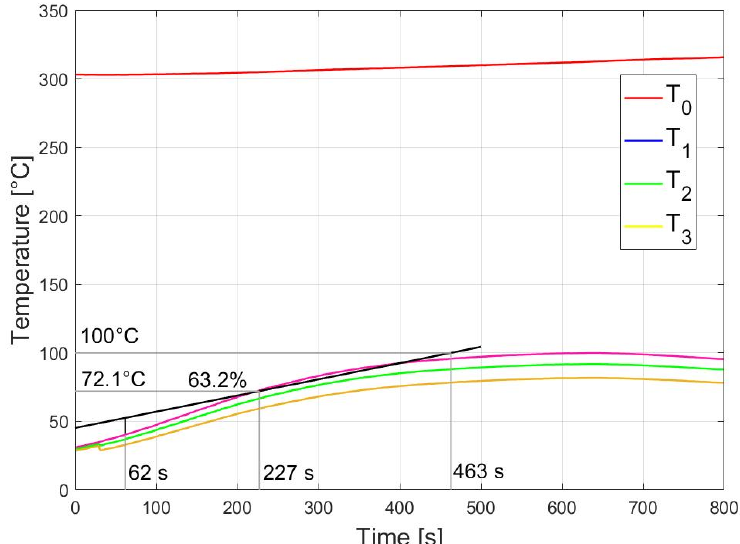
Figure 10. Time constant determined using the “tangent” method. T 0 is an impact temperature of an external temperature field, T 1 is the temperature measured at a place 0.2 m away from the heat source, T 2 is the temperature measured at a place 0.4 m away from the heat source, and T 3 is the temperature measured at a place 0.6 m away from the heat source. The black line is the mark’s tangent, and the gray lines are the guidelines.